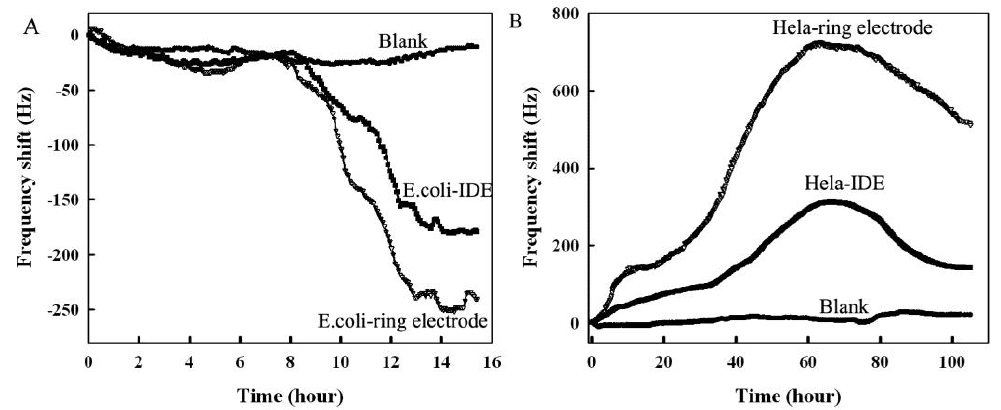
Figure 7. Real-time monitoring of the growth of E . coli or HeLa cells. ( A ) Real-time monitoring of the growth of E . coli . ( B ) Real-time monitoring of the growth of HeLa cells.